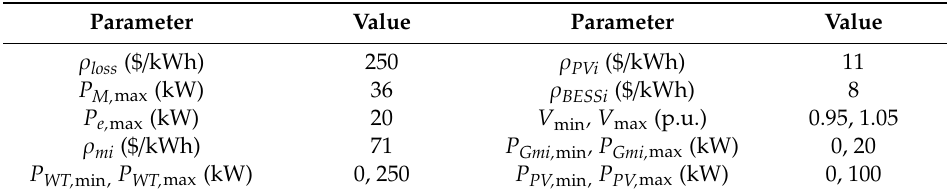
Table 1. Values of technical parameters.